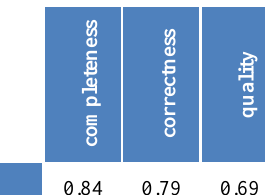
Figure 5: Area used for quality assessment of classification results for 2013 with full parameters set